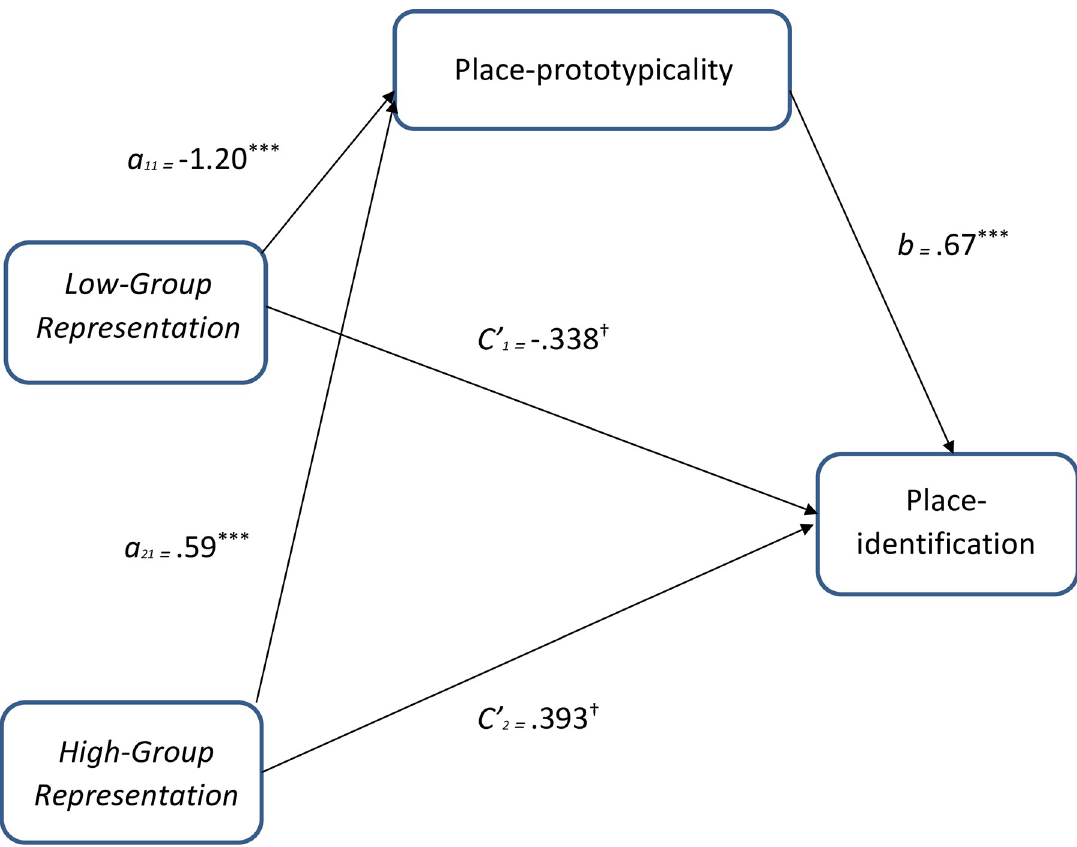
Fig 1. Study 1a mediation analyses for the relative indirect effects of low- and high-group representation conditions (as compared to the control condition—equal representation) on place-identification, via place-prototypicality. † p = .07, � p < .05, �� p < .01, ��� p <